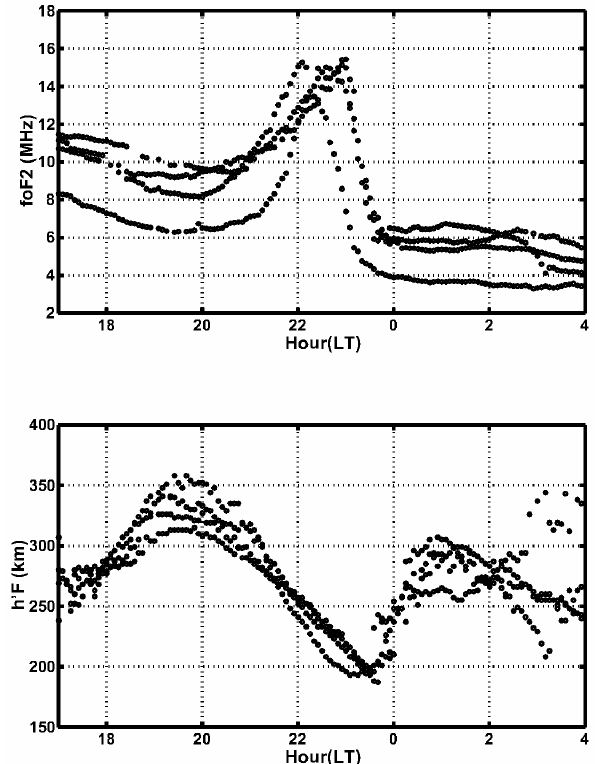
Fig. 3. Superimposed variations in fo F2 (upper) and h 0 F (lower) observed at Vanimo over the period 1–4 November Fig.3. Superimposed variations in foF2 (upper) and h’F (lower) observed at Vanimo over the period 1-4 November 1997.